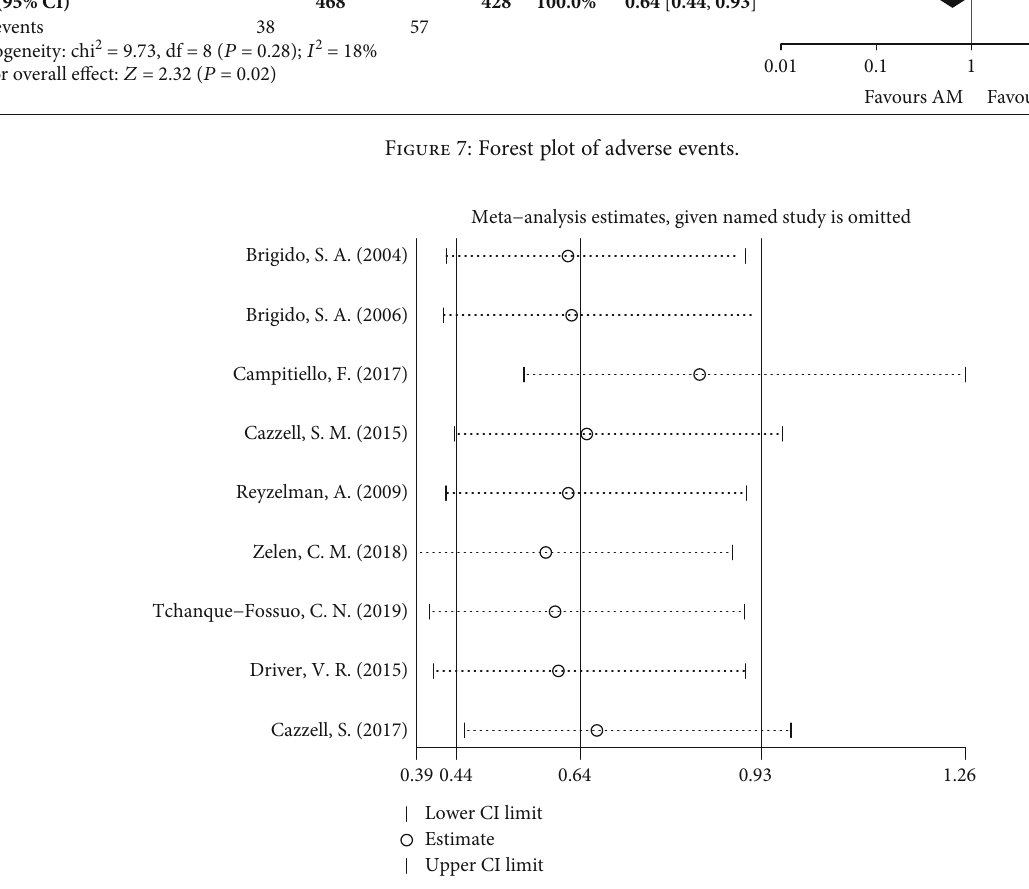
Figure 8: Sensitivity analysis of adverse events. Table 2: Egger ’ s test and Begg ’ s test for the